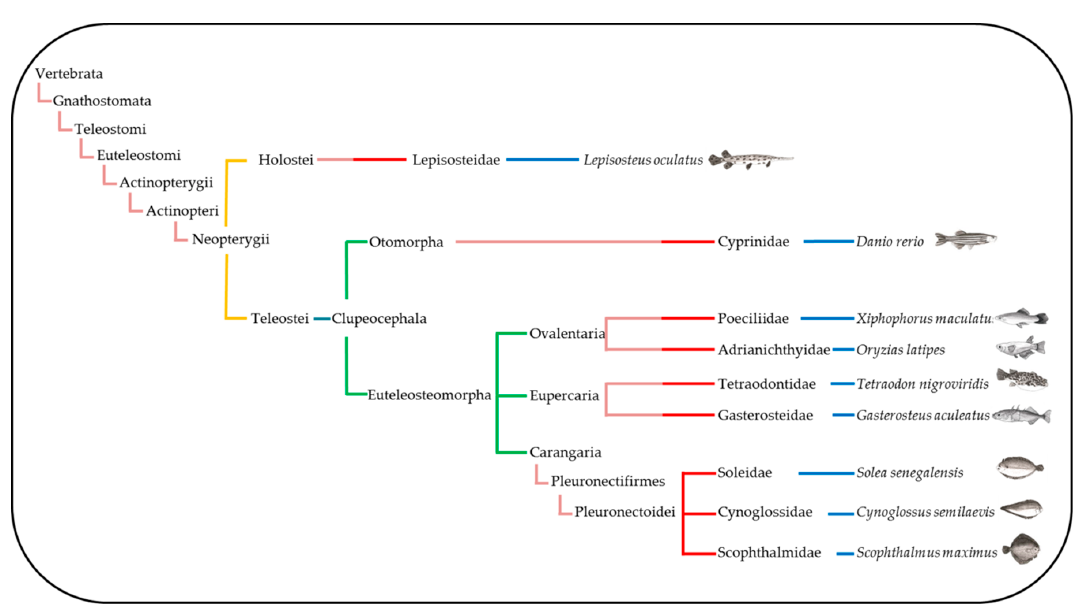
Figure 5. Taxonomic tree showing the species of fishes included in this work.